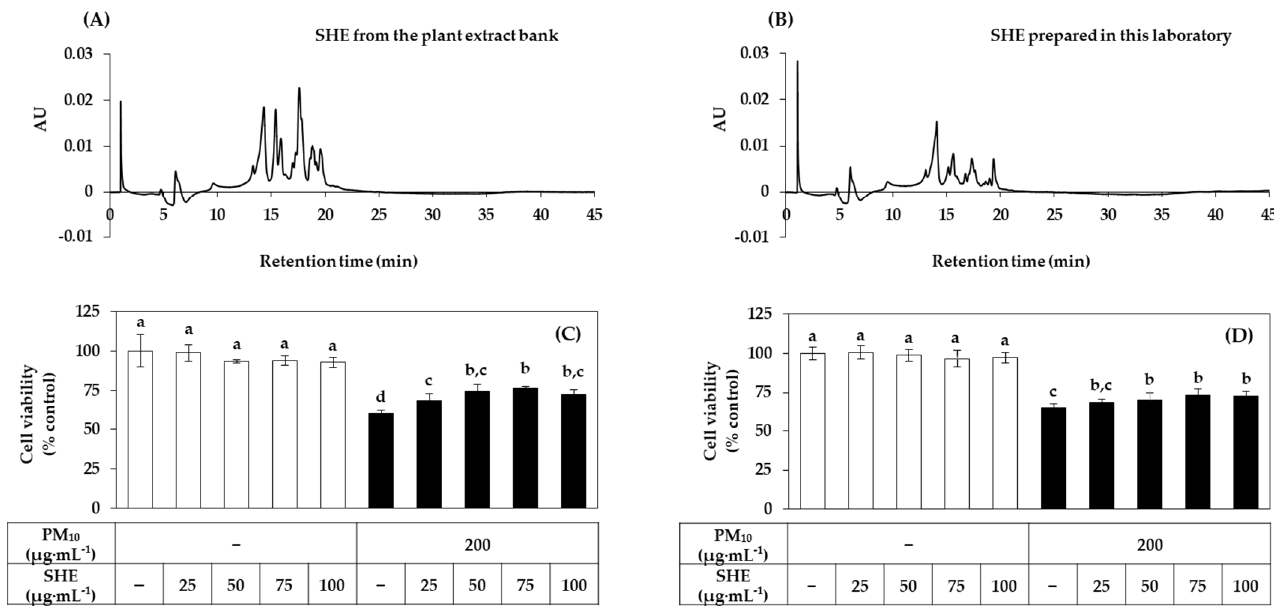
Figure 2. Comparison of Siegesbeckiae Herba extracts (SHEs) purchased from the plant extract bank and prepared in this laboratory. For the comparison of phytochemical composition, high-performance liquid chromatography (HPLC) profiles of the SHEs from the plant extract bank ( A ) and prepared in this laboratory ( B ) are shown (concentration 0.1%). For the comparison of bioactivity, HaCaT keratinocytes were treated with SHEs from the plant extract bank ( C ) and prepared in this laboratory ( D ) at different concentrations and cultured in the absence or presence of PM 10 (200 μ g mL − 1 ) for 48 h. Cell viability was determined by the MTT assay. Data are presented as mean ± SD ( n = 4). Duncan’s multiple range test was performed to compare all group means to each other. Groups that share the same letters (a–d) do not have significantly different means at the p < 0.05 level.